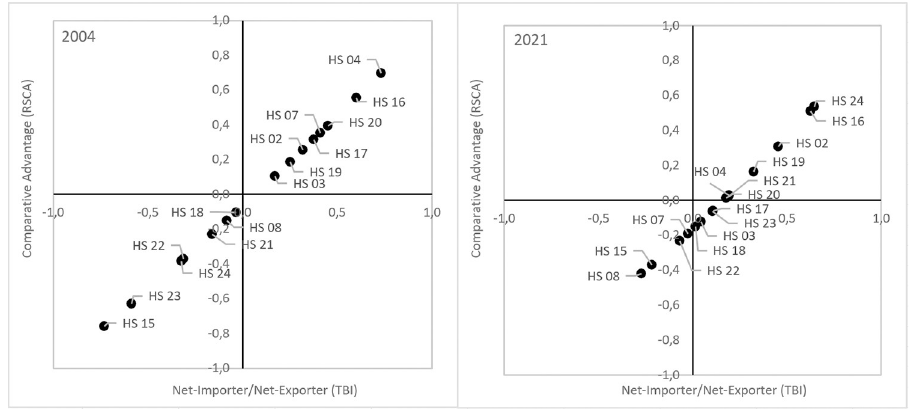
Fig 9. Products mapping for selected agri-food product groups exported from Poland to the other EU countries in 2004 and 2021 (Widodo’s method). Source: [13], the authors’ elaboration.